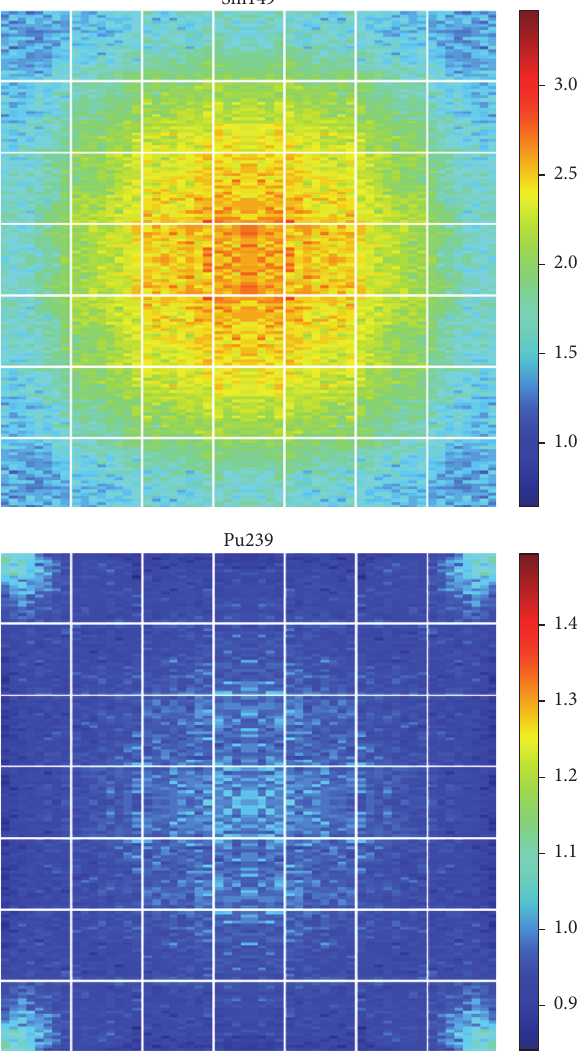
Figure 9: Uncertainty on local isotopic concentrations for some Pu241 and Xe135 at 48000 MW ⋅ d/t (% at 1𝜎 ).